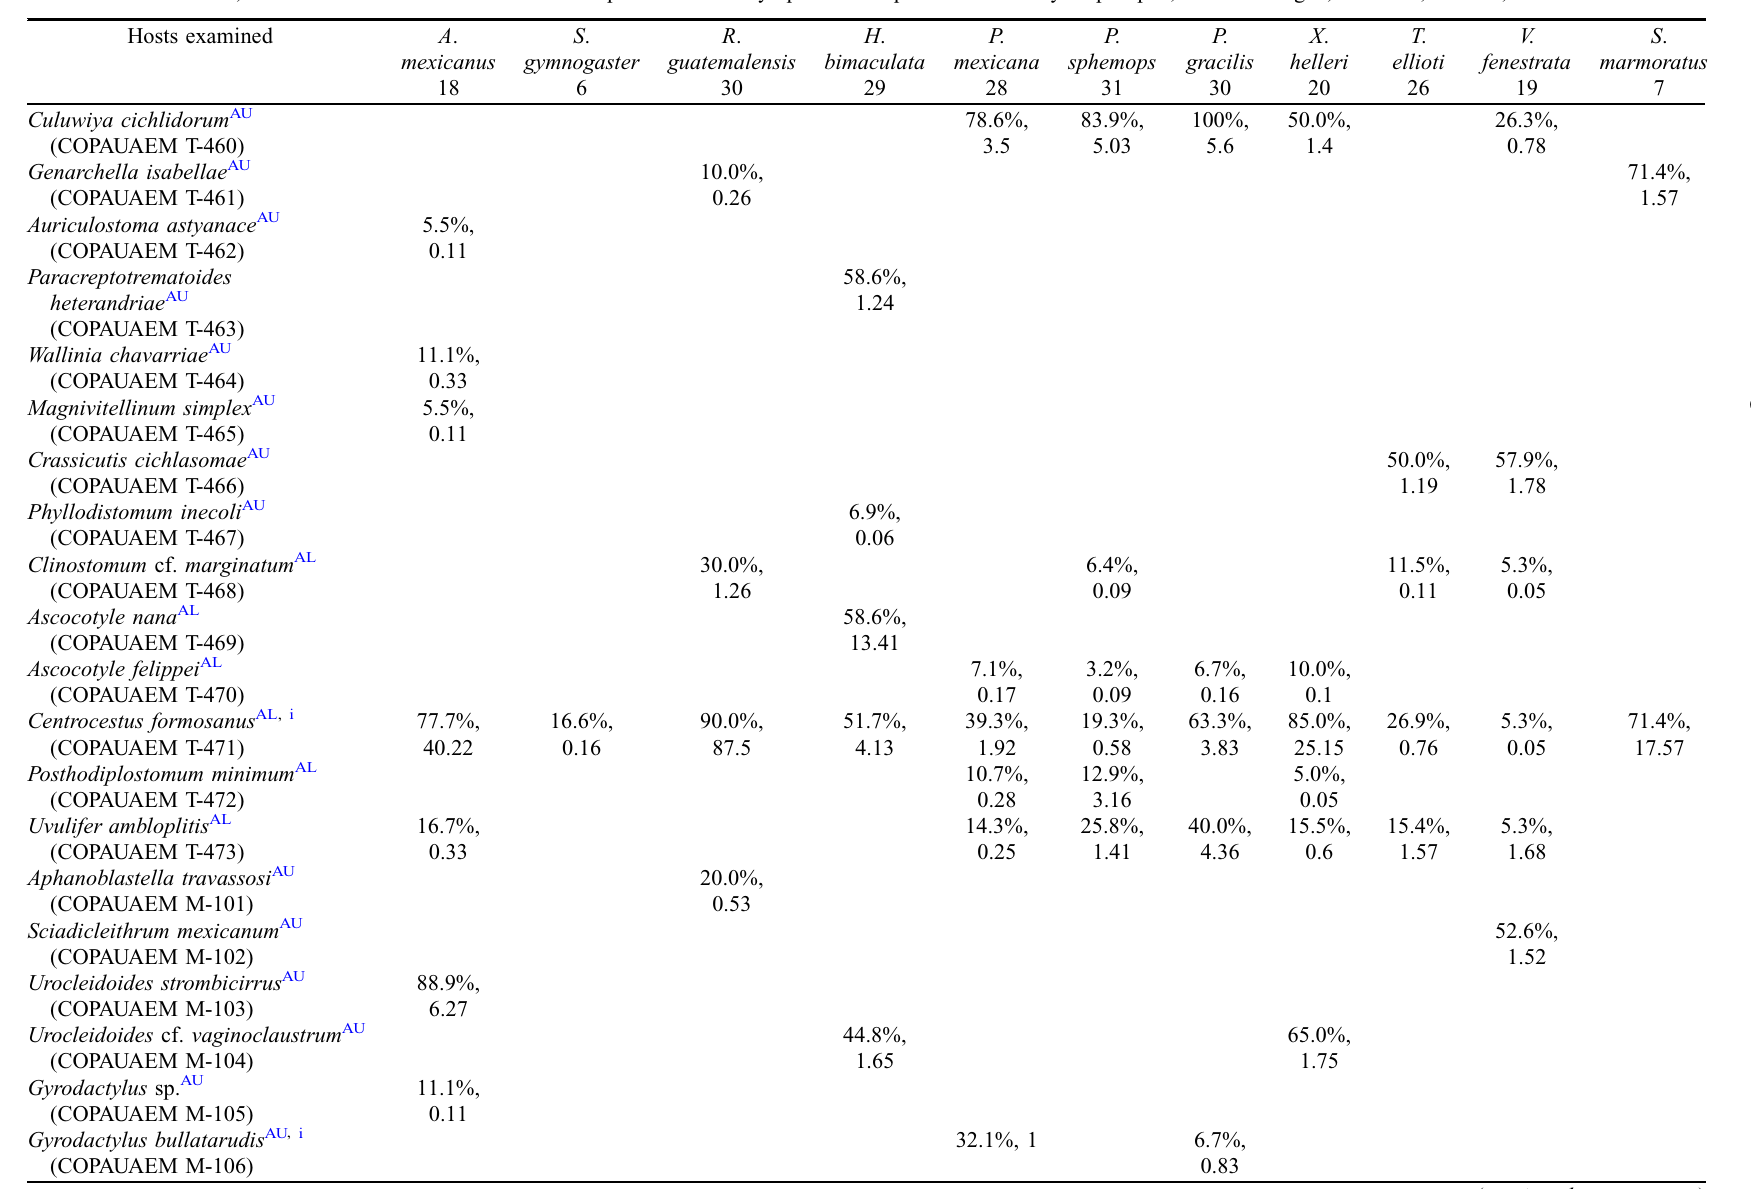
Table 1. Prevalence %, and abundance of 36 taxa of helminth parasites of 11 sympatric fish species from Arroyo Apazapan, Río La Antigua, Veracruz, Mexico, November 2009. Hosts examined A . S mexicanus